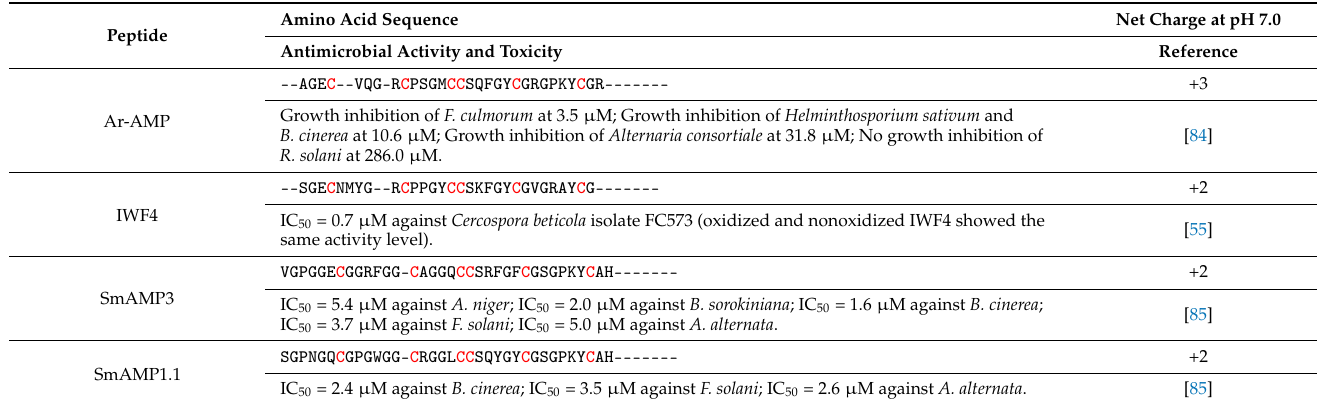
Table 2. Cont. Amino Acid Sequence Net Charge at pH 7.0 Peptide Antimicrobial Activity and Toxicity Reference –-AGEC–-VQG-RCPSGMCCSQFGYCGRGPKYCGR––––––- +3 Growth inhibition of F. culmorum at 3.5 µ M; Growth inhibition of Helminthosporium sativum and Ar-AMP B. cinerea at 10.6 µ M; Growth inhibition of Alternaria consortiale at 31.8 µ M; No growth inhibition of R. solani at 286.0 µ M. IWF4